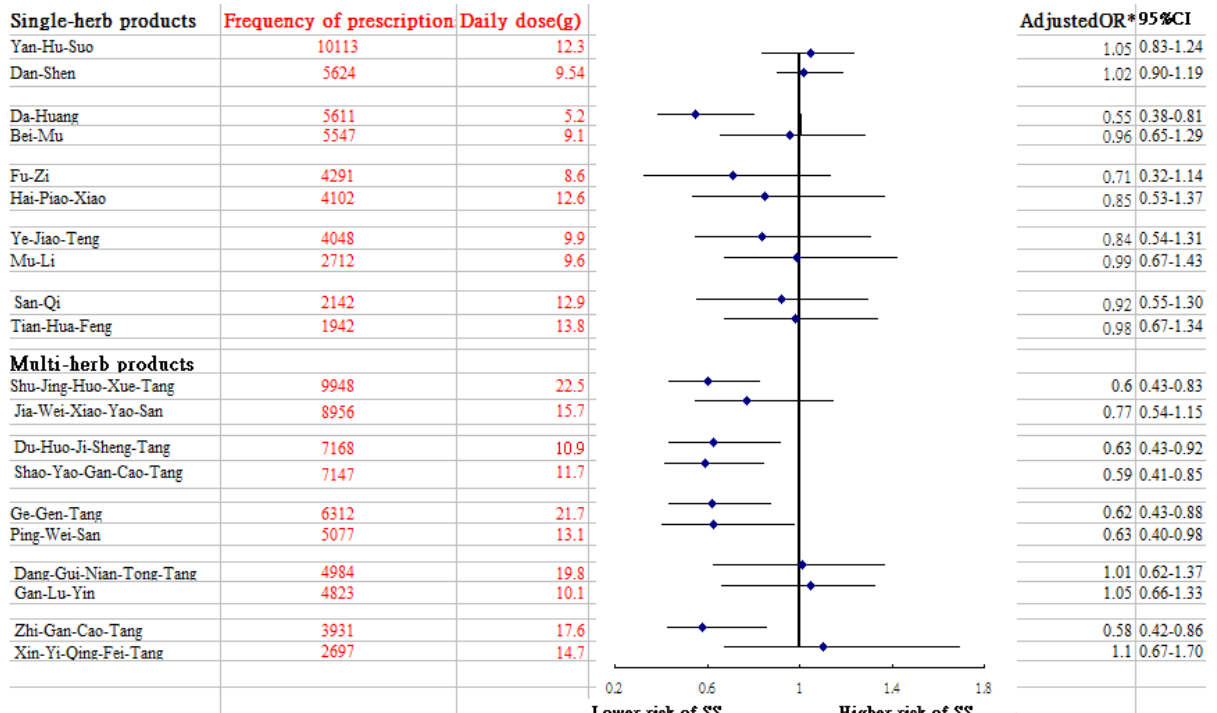
Table 3. SS risk for RA patients with and without CHM use stratified by sex and age.